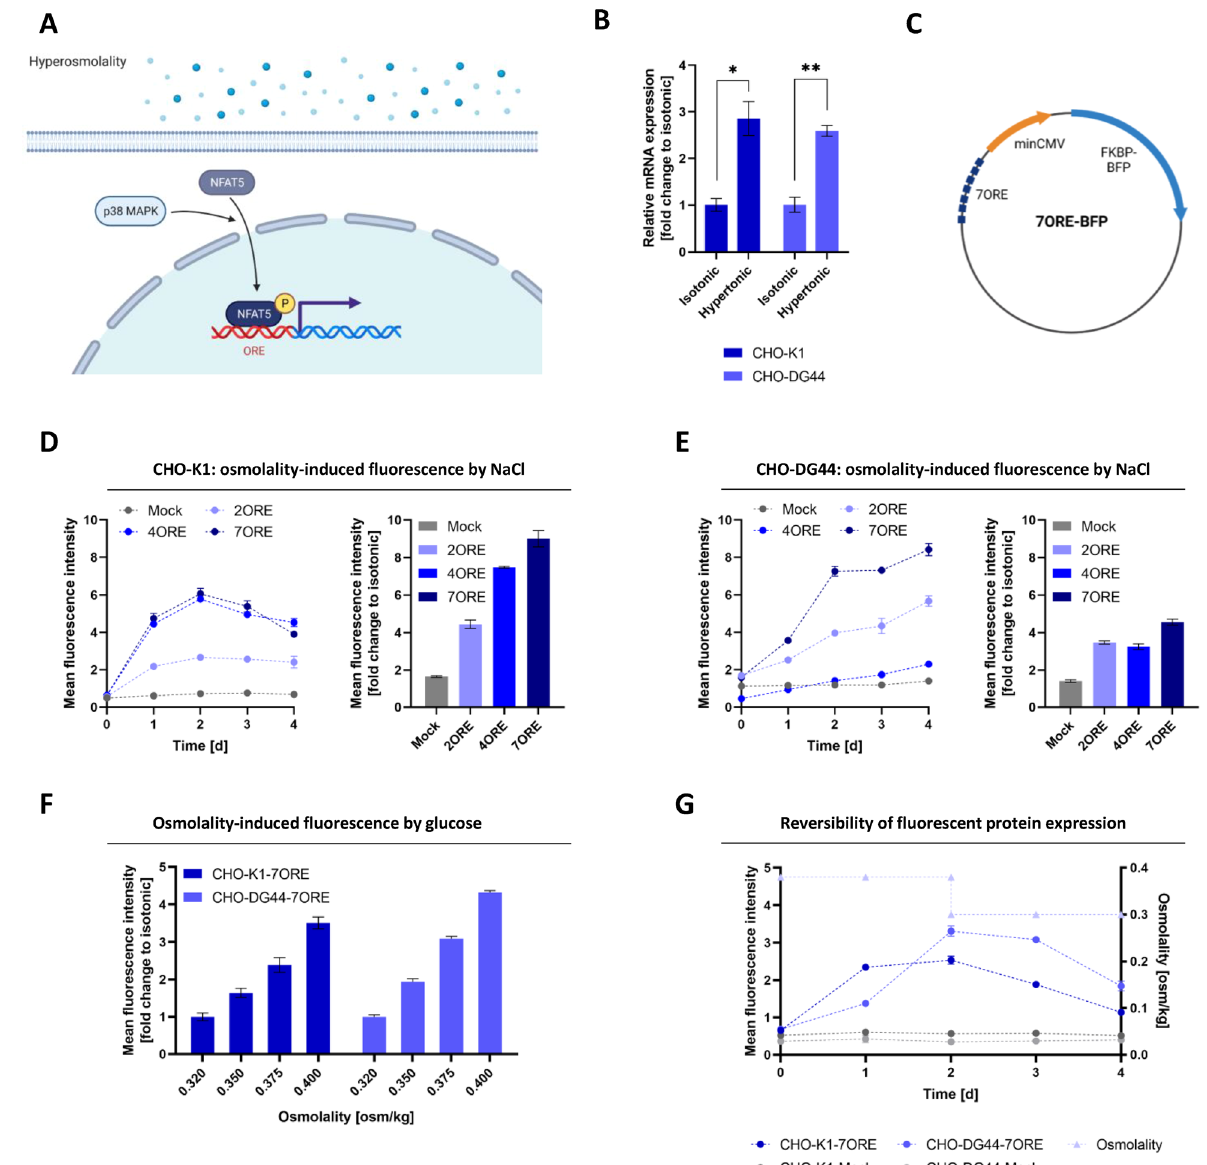
Figure 2. Development of a hyperosmolality-sensitive expression system. ( A ) Hyperosmolality signaling pathway. ( B ) qPCR of NFAT5 expression in CHO-K1 and CHO-K1-DG44 cells under isotonic and hyperosmotic conditions. ( C ) Schematic illustration of the hyperosmolality inducible FKBP-BFP expression vector. ( D ) Flow cytometric analysis of NaCl-induced hyperosmotic cultured CHO-K1 cells (left) and relative fold-change of mean fluorescence against the isotonic cultured control (right). ( E ) Flow cytometric analysis of NaCl-induced hyperosmotic cultured CHO-DG44 cells (left) and relative fold-change of mean fluorescence against the isotonic cultured control (right). ( F ) Flow cytometric analysis of glucose-induced hyperosmotic cultured CHO-K1 and -DG44 cells with relative fold-change of mean fluorescence against the isotonic cultured control. ( G ) Flow cytometric analysis of hyperosmotic cultured CHO-K1 and -DG44 cells with restoration of isotonic conditions after 2 days. [n = 3 replicates, Mean ± SD; * = p < 0.05; ** = p <